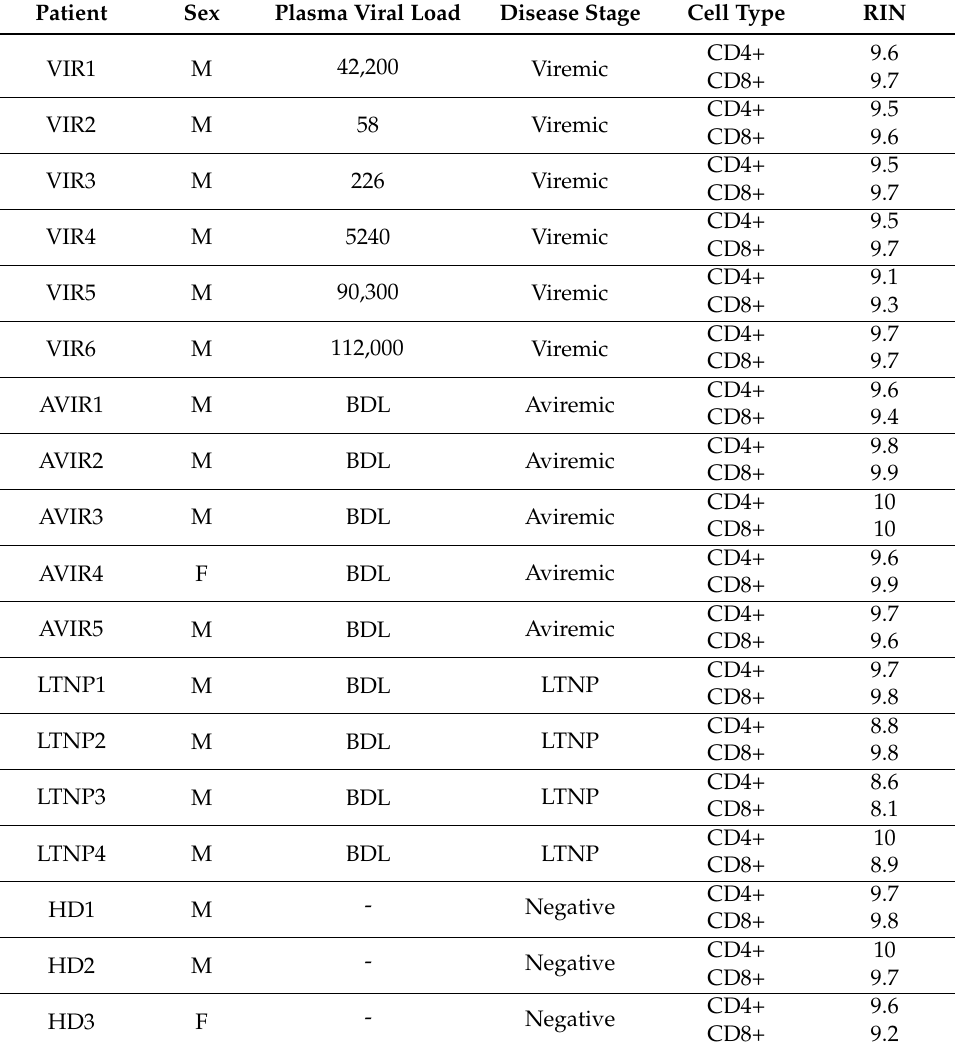
Table 1. Clinical profiles of the study patients, and